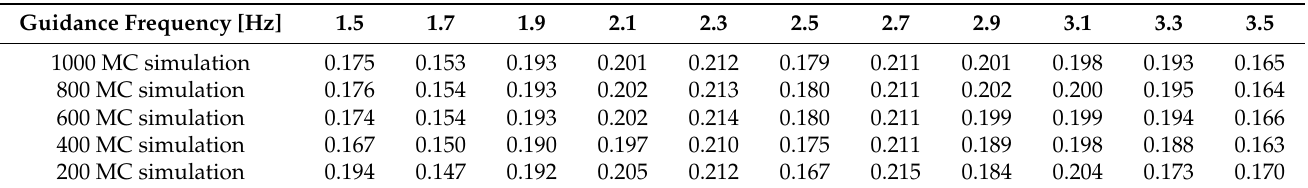
Table 5. The coefficient of variation for the second harmonic of different numbers of MC